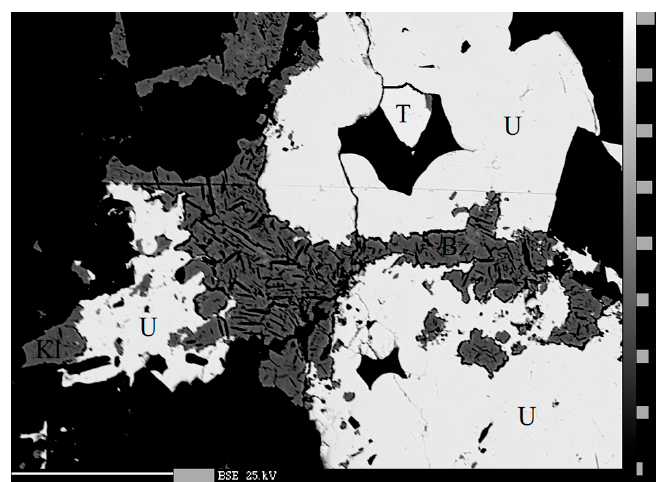
Figure 38. A euhedral tiemannite crystal (T) occurs in the cavity of uraninite aggregates (U), in the association are Cu-selenides (dark grey) including klockmannite (Kl) and berzelianite (Bz). BSE photograph. P ř íbram, a dump of shaft 16. Photo by J. Sejkora and P. Škácha. Minerals 2017 , 7 , 91